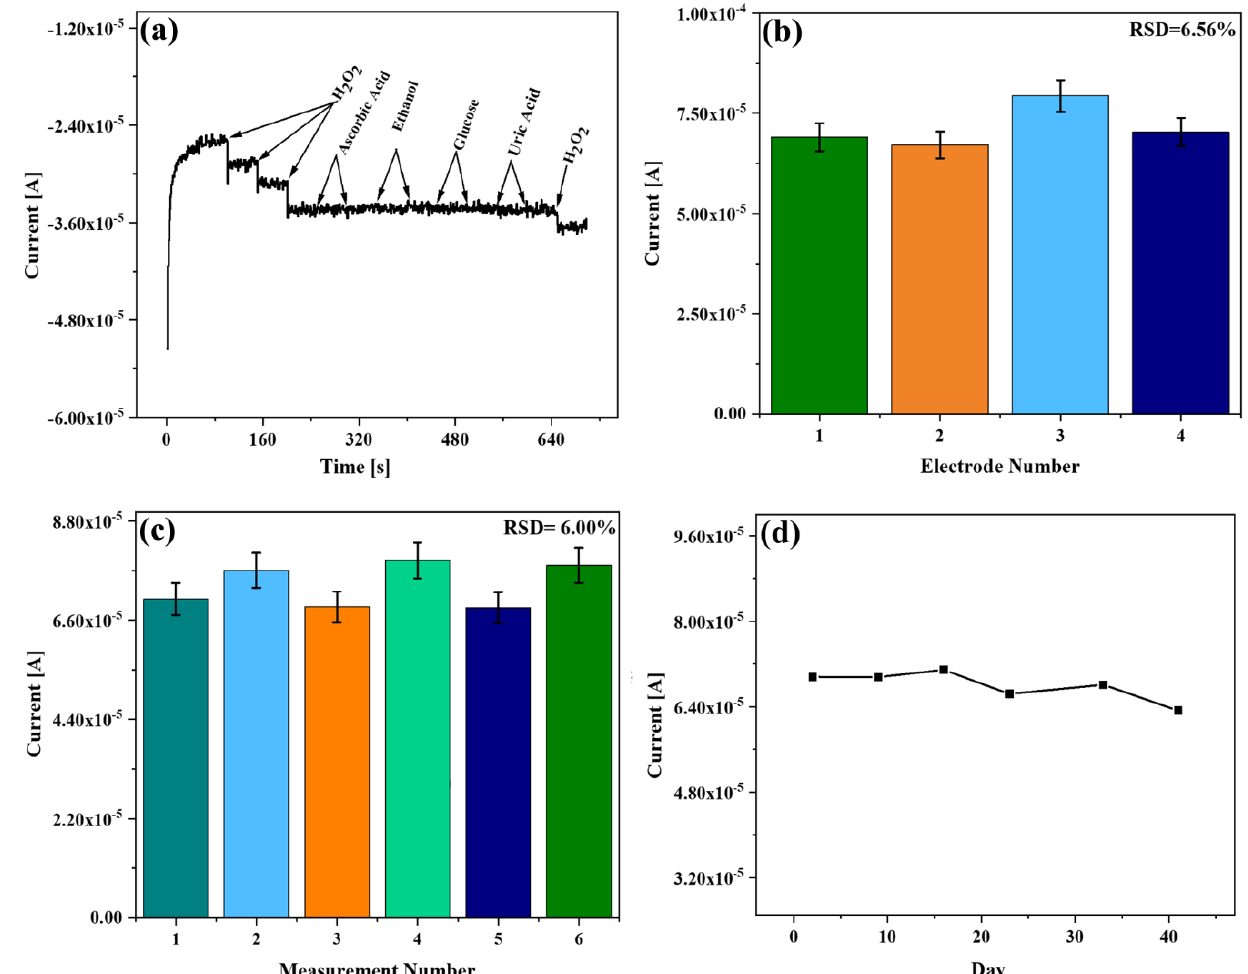
Figure 7. ( a ) Selectivity study of Au NPs/SnO 2 NFs composite electrode exposed to H 2 O 2 , ascorbic acid, ethanol, glucose, and uric acid in 0.1 M PBS (pH 7.0) at E = −0.82 V; ( b ) CV-based reproducibil- ity study; ( c ) repeatability study of the Au NPs/SnO 2 NFs composite electrodes in 0.1 M PBS at a 17 mV/s scan rate containing 5 mM of H 2 O 2 ; ( d ) CV based response stability study of Au NPs/SnO 2 NFs composite electrode with 5 mM of H 2 O 2 in 0.1 M PBS at 17 mV/s.